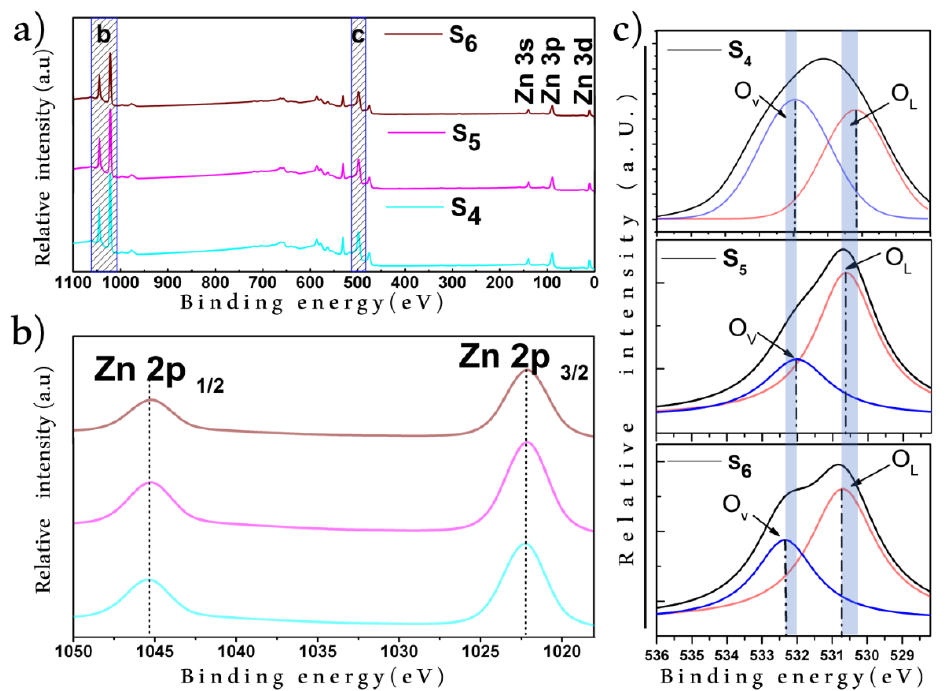
Figure 3. Comparison between the XPS spectra of the ZnO nanofilms supported on the Si substrate after controlled sublimation at 600 (S 1 ), 700 (S 2 ), and 800 °C (S 3 ): ( a ) complete spectra; ( b ) spectra in the 1050 – 1020 eV binding energy range; ( c ) spectra in the 536 – 528 eV binding energy range.